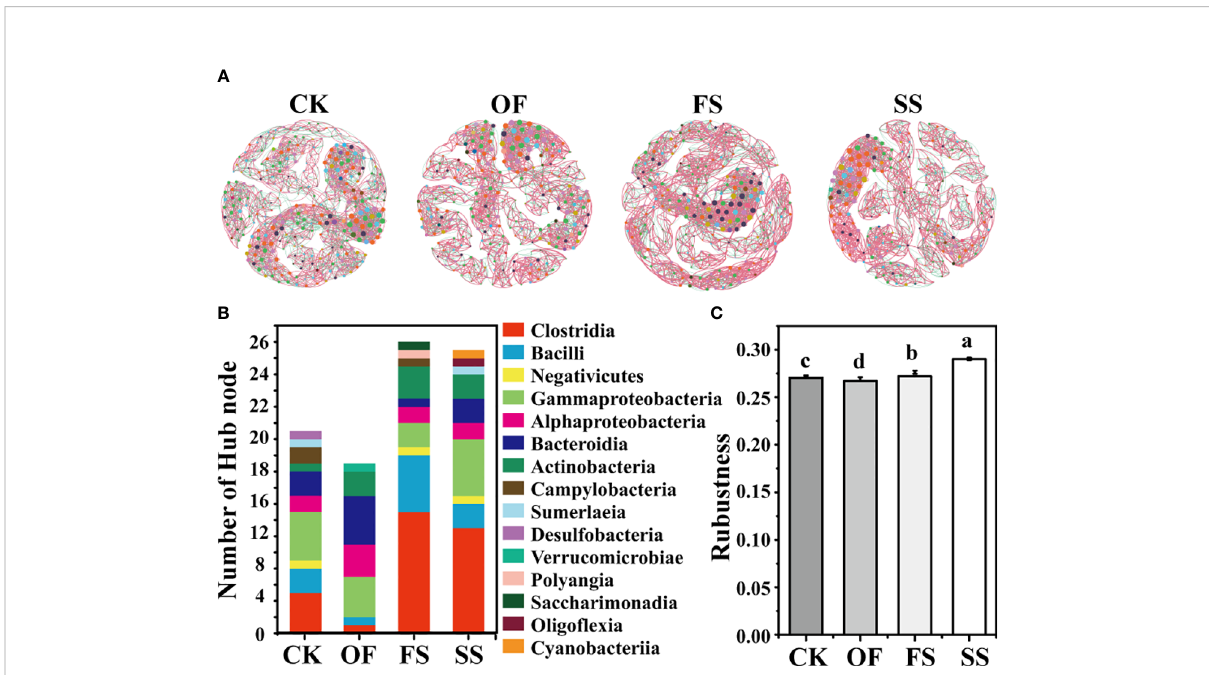
FIGURE 5 (A) Co-occurrence networks between bacterial taxa based on genus at the Class level according to the Pearson correlation coef fi cients (Nodes labeled with the same color indicate that different genera belonged to the same bacterial Class. Node size denotes link numbers with other nodes and larger sizes indicate more link numbers. The edge represents the connected line between two nodes with signi fi cant correlation (Pearson ’ s correlation coef fi cient > 0.6, P < 0.05). The red and green lines within the two nodes in the networks refer to positive and negative correlations, respectively). (B) The columnar stack diagram shows the distribution of the hub nodes of the bacterial co-occurrence network at the taxonomic level of class. (C) Robustness of the bacterial co-occurrence network in different samples (the different lowercase letters of the same index in different sample groups indicate that there is a signi fi cant difference between the groups in this index (according to Duncan's signi fi cance test, P <